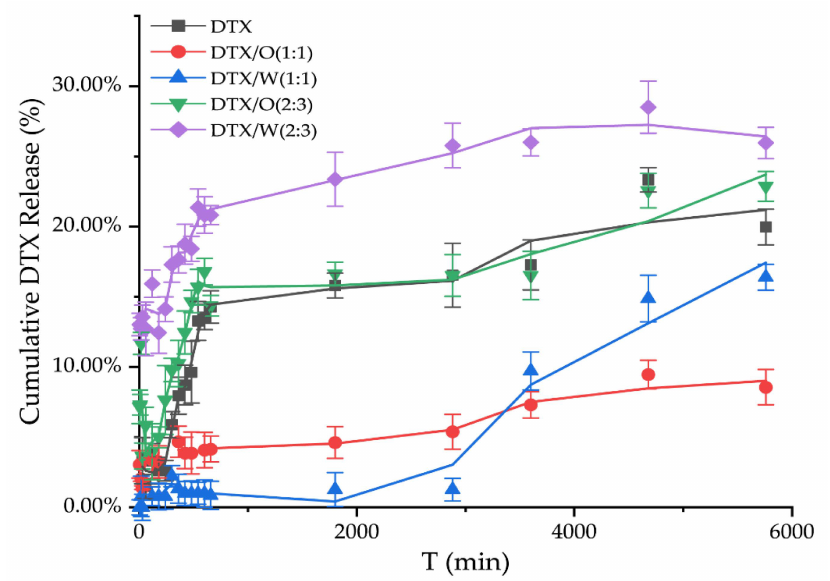
Figure 4. In vitro release studies of DTX solution and DTX-containing emulsions were based on the differences in the dosages of stearic acid and Vaseline in the emulsion, 2.5 g and 2.5 g (1:1), and the dosage was 1.0 g and 1.5 g (2:3) in the 10 mL system,